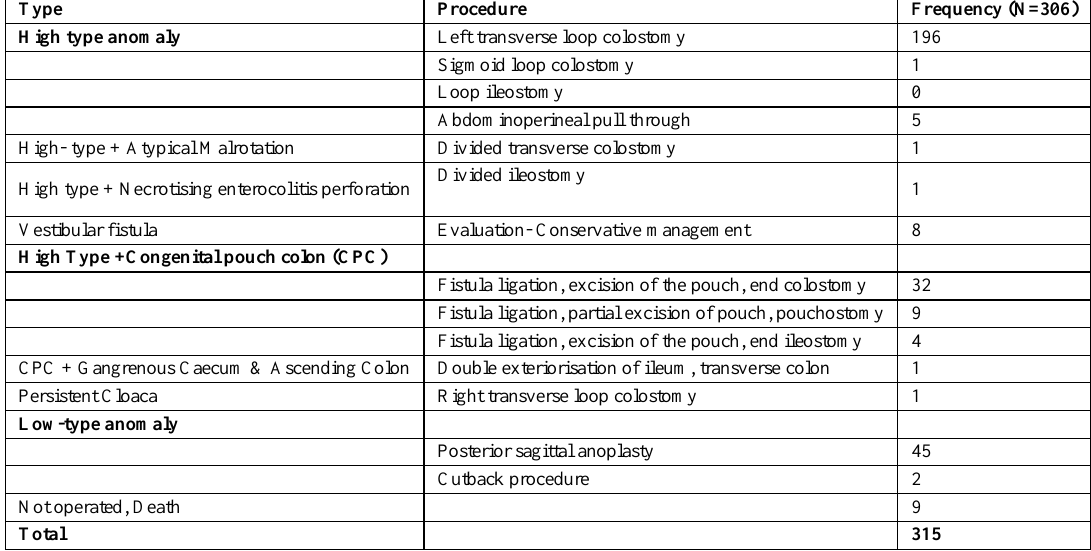
Table 4: Summary of procedures for ARM in the present study